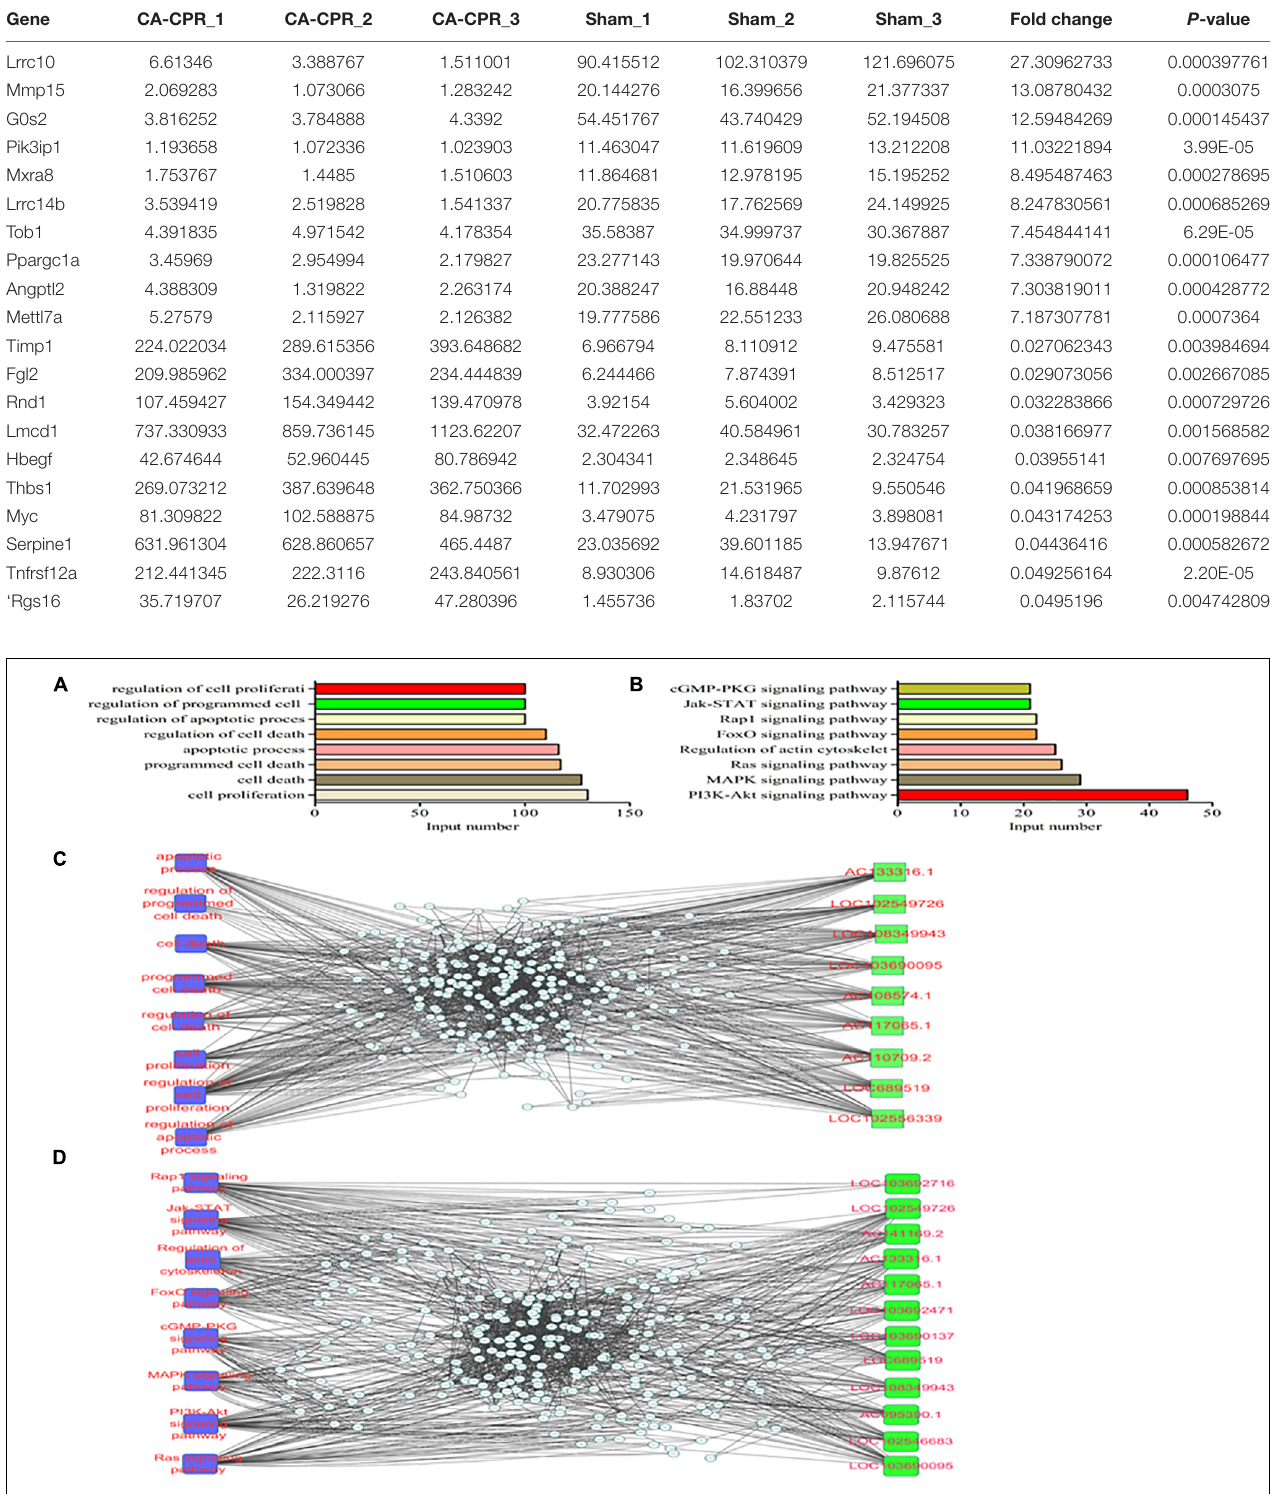
FIGURE 3 | GO and KEGG analyses of the differentially expressed mRNAs in the two groups. (A) GO analysis; (B) KEGG analysis; (C) lncRNAs-miRNAs-mRNAs interaction network of the key genes; (D) lncRNAs-miRNAs-mRNAs interaction network of the key pathways.